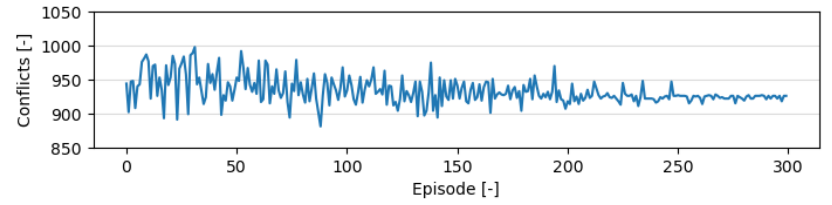
Figure 16. Total number of pairwise conflicts per episodes during the training of the RL